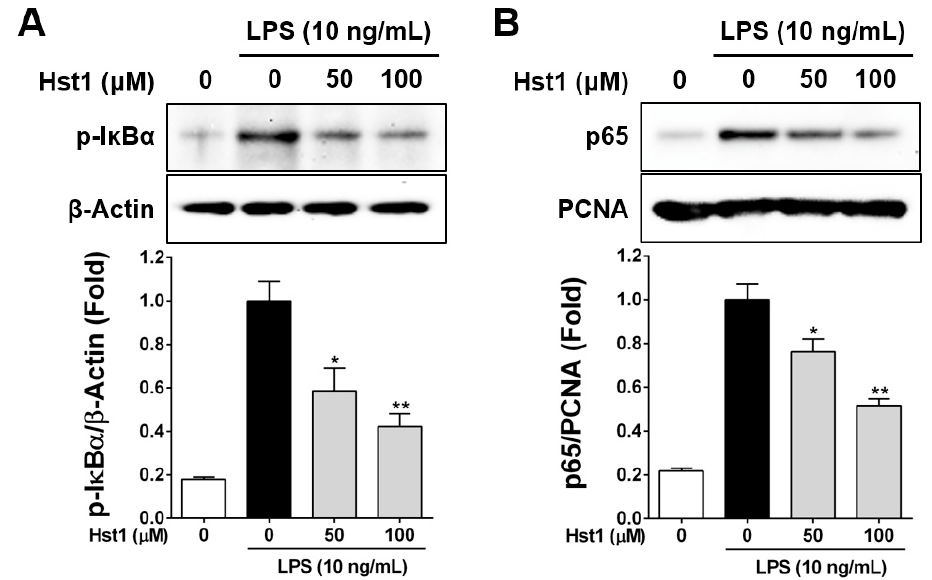
Figure 4. Effects of the Hst1 on the phosphorylation of I κ B- α and nuclear translocation of NF- κ B LPS-induced RAW264.7 macrophage cells. RAW264.7 cells were starved for 6 h, pre-treated with Hst1 at the indicated concentrations (50 and 100 µM) for 2 h and then exposed to Hst1 with LPS (10 ng/mL) or LPS alone for 2 h. ( A ) Whole-cell lysates were analyzed by Western blot analysis using a specific anti-phospho-I κ B- α antibody. The blot was stripped and reprobed with an antibody against β -Actin. β -Actin was used as the internal control. Analysis reveals that p-I κ B- α induction by LPS is reduced by treatment with Hst1 in RAW cells. ( B ) Nuclear extracts were prepared from RAW264.7 cells. RAW264.7 cells were treated by the same procedure for whole-cell lysates Western blot analysis and were analyzed using an anti-p65 antibody. The blot was stripped and reprobed with an antibody against PCNA to verify equal loading of proteins in each lane. These results are displayed in fold of LPS alone samples. Results indicate that the increased ratio of p65 to PCNA levels induced by LPS in RAW cells was statistically significantly reduced by treatment with Hst1. Each value represents the mean ± SD and is representative of results obtained from three independent experiments. * p <